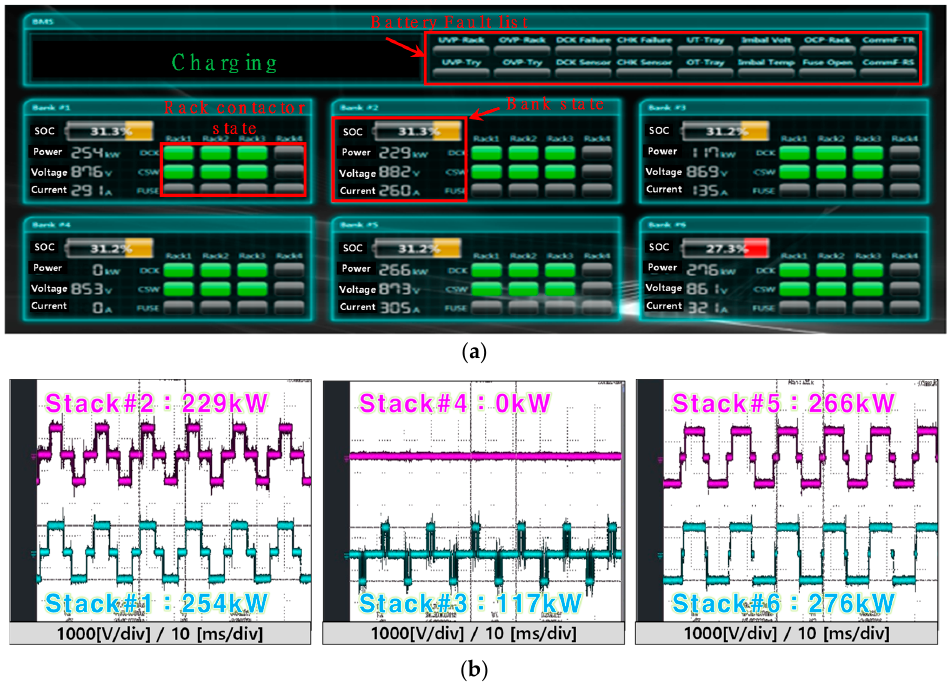
Figure 20. Results of battery balancing according to RPR mode: ( a ) Battery condition for each bank measured on the PMS and ( b ) output waveform of each cell inverter measured by the oscilloscope.